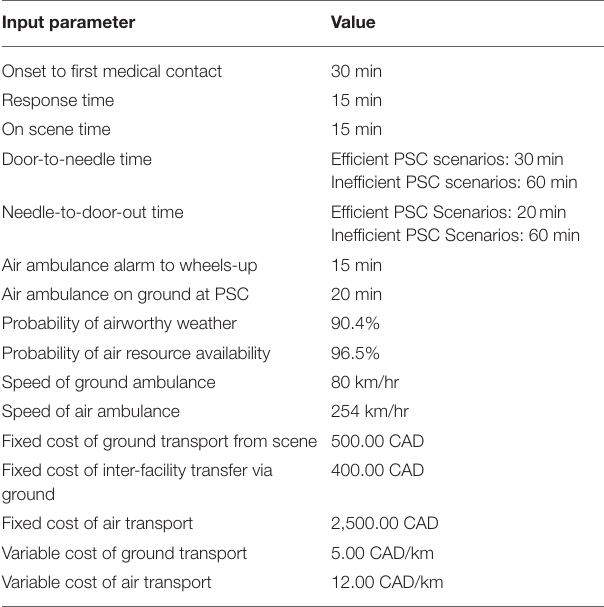
TABLE 3 | Definition for variables used in formulations. TABLE 4 | Assumed parameters used in the model for the generated